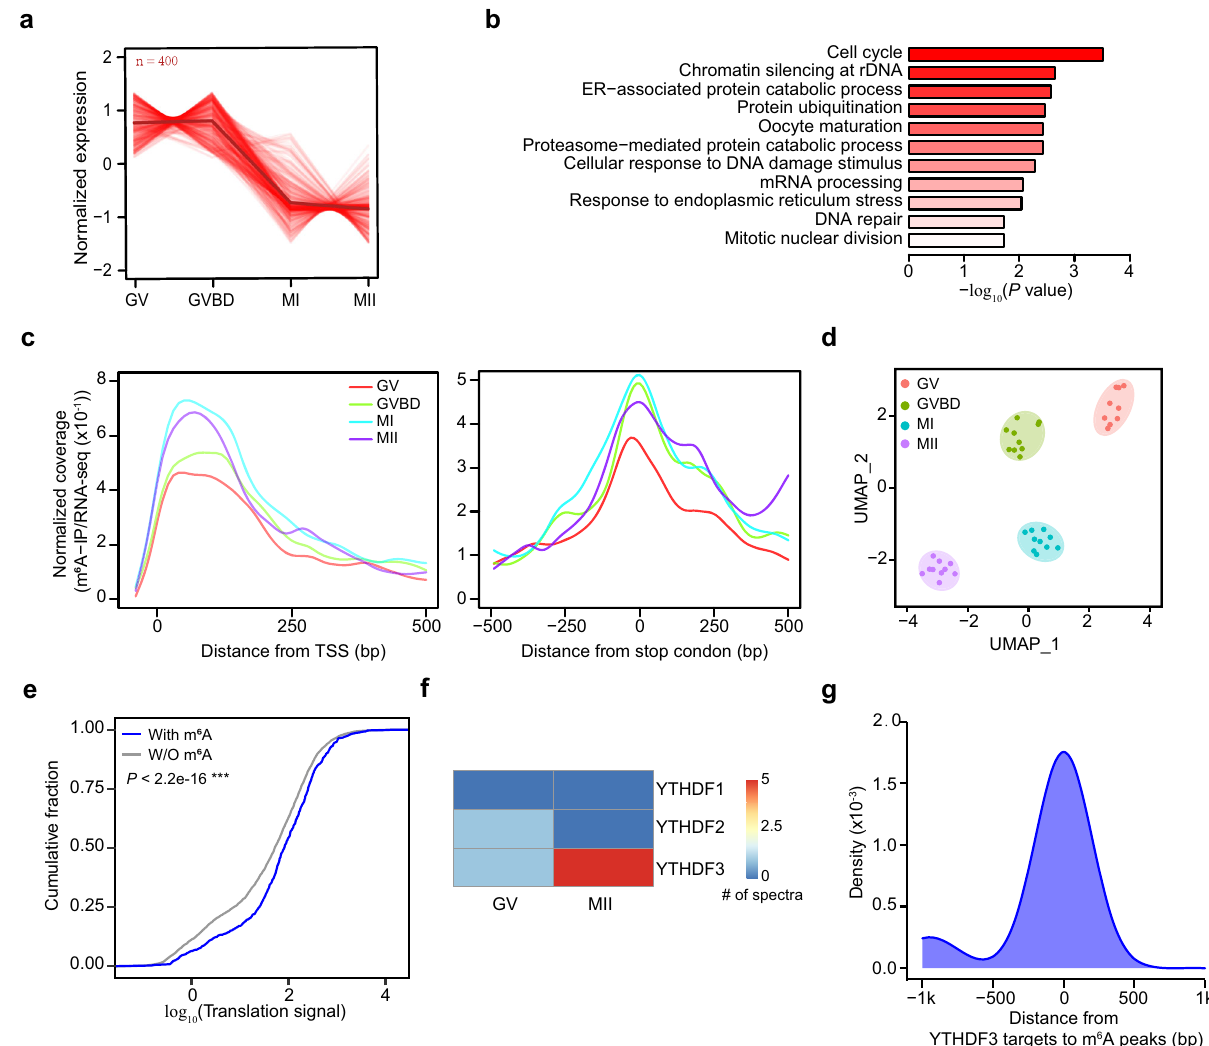
Fig. 4 | The dynamic m 6 A landscape during oocyte maturation. a Line plot showing the decrease in expression of the gene set during oocyte maturation as indicatedbyK-meansclustering. b BarplotdisplayingtheenrichedGeneOntology (GO) terms in the gene set showing in ( a ). The enrichment and P value were cal- culated with default parameters using hypergeometric test of functional annota- tion in DAVID database. c Metagene pro fi les depicting m 6 A signals in areas surroundingthetranscriptionstartsite(TSS)(left)andstopcodon(right).Colored lines represent different stages of oocyte maturation. d Uniform manifold approximation and projection (UMAP) clustering for oocytes at different stages